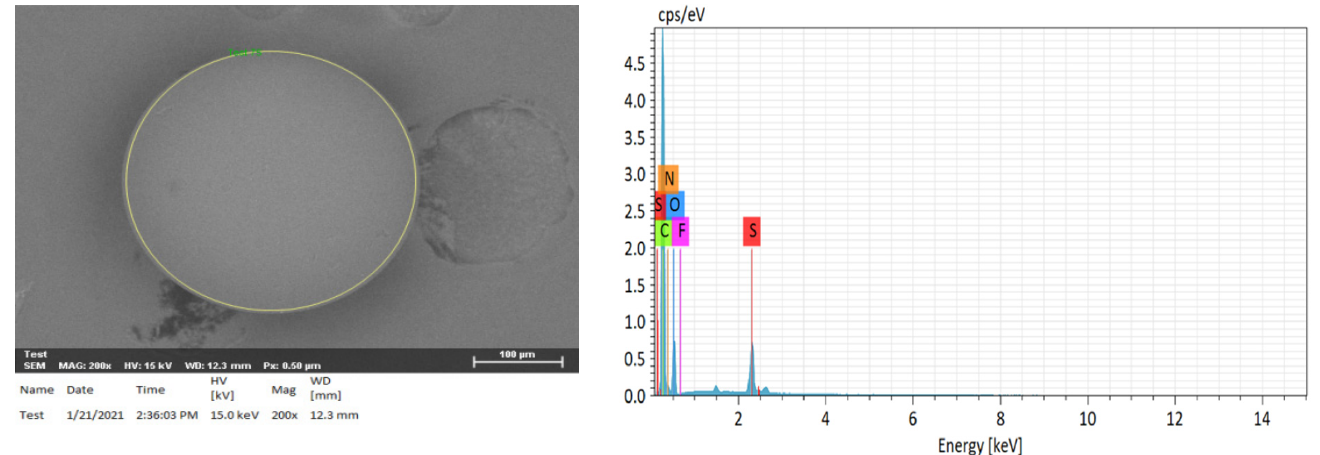
Figure 4. SEM-EDX image of H + Dowex-M4195 chelating resin.